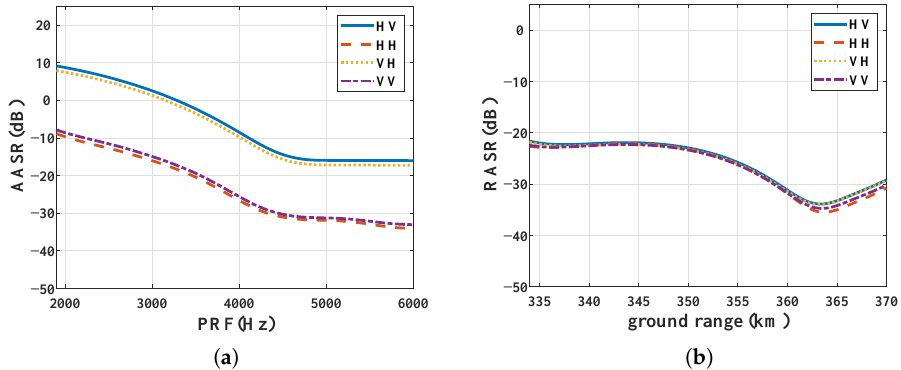
Figure 6. AASR and RASR performance of ± π /4 quad-pol SAR system (system #1). ( a ) AASR versus PRF; ( b ) RASR (PRF = 3756 Hz) versus the ground